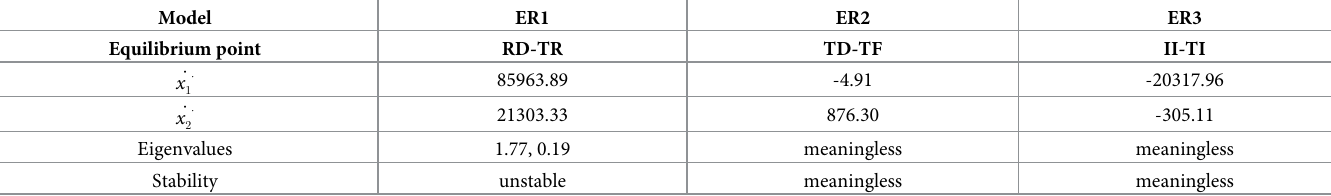
Table 7. Equilibrium state analysis